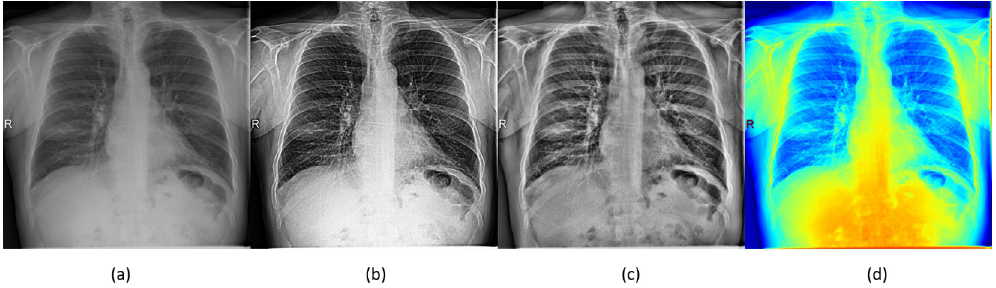
Fig 3. The original image (a) and the results of the selected image pre-processing techniques—(b) Unsharp Masking and Histogram Equalisation (c) CLAHE (d) Psuedo-Coloring.